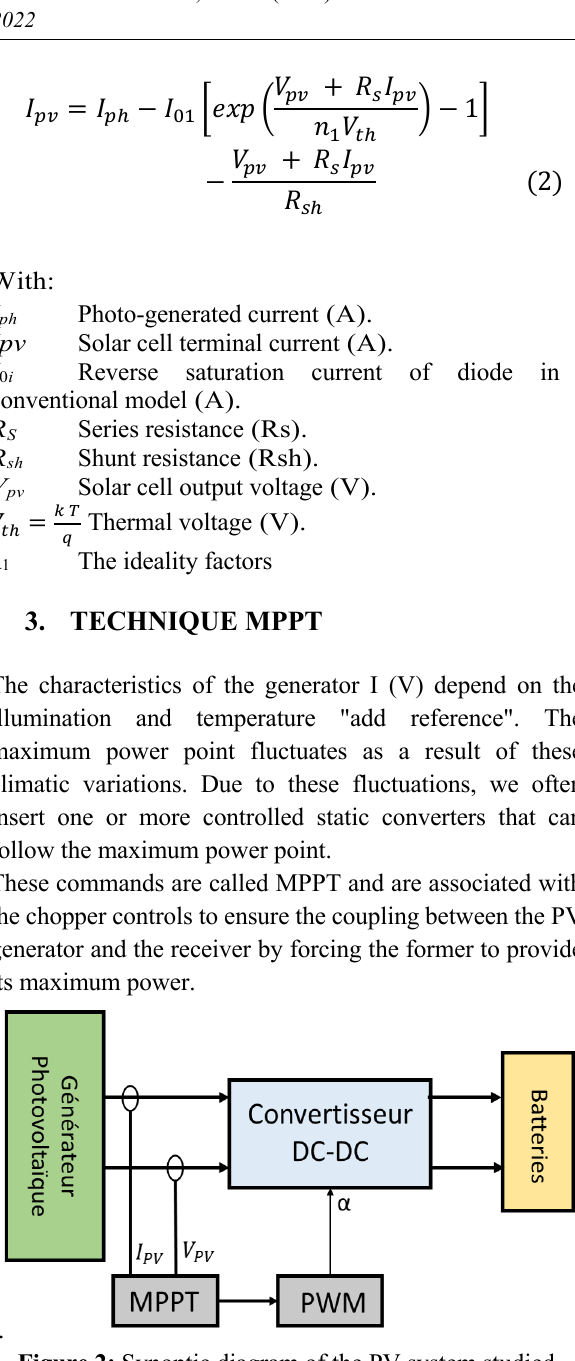
Figure 2: Synoptic diagram of the PV system studied